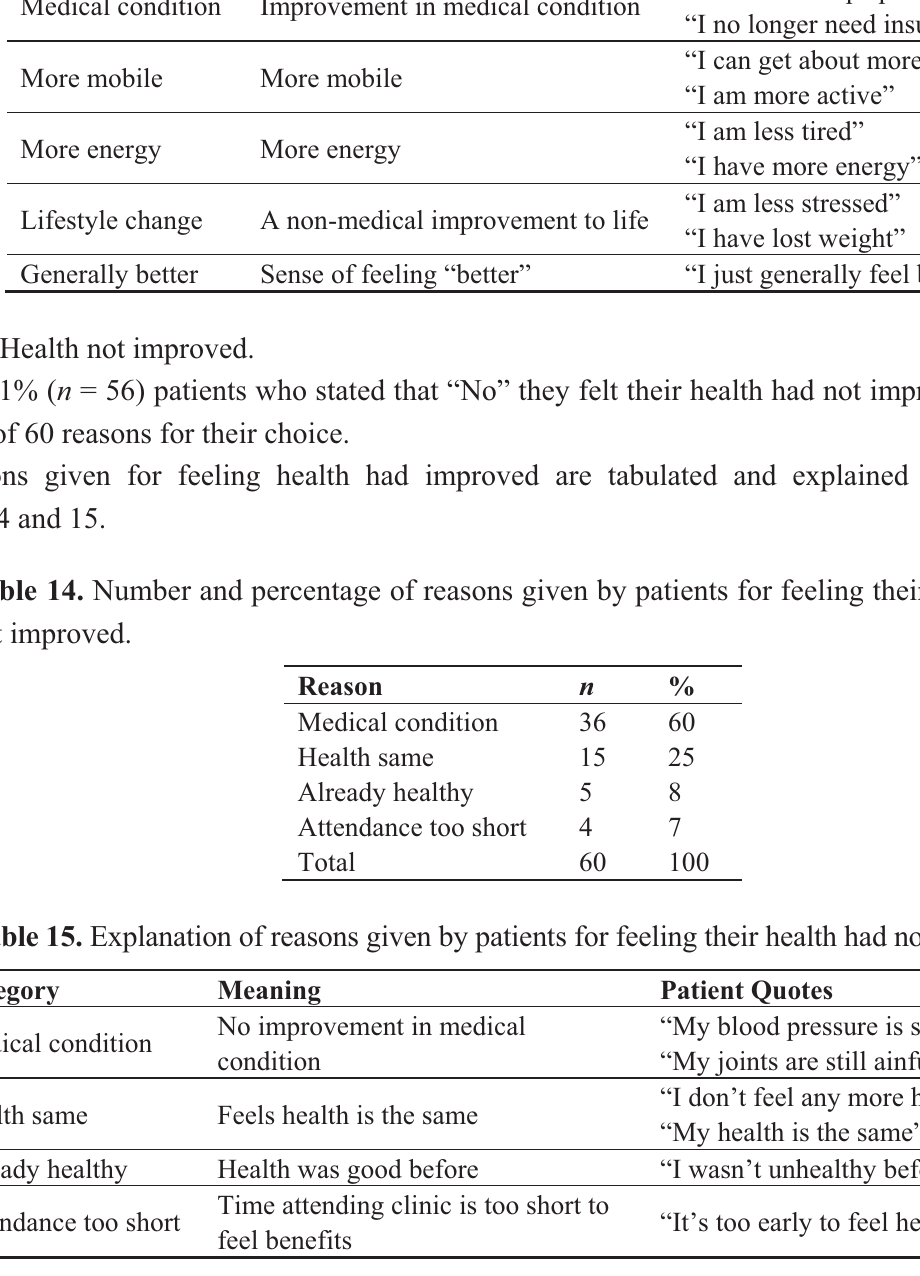
Table 13. Explanations of reasons given by patients for their health had improved. Category